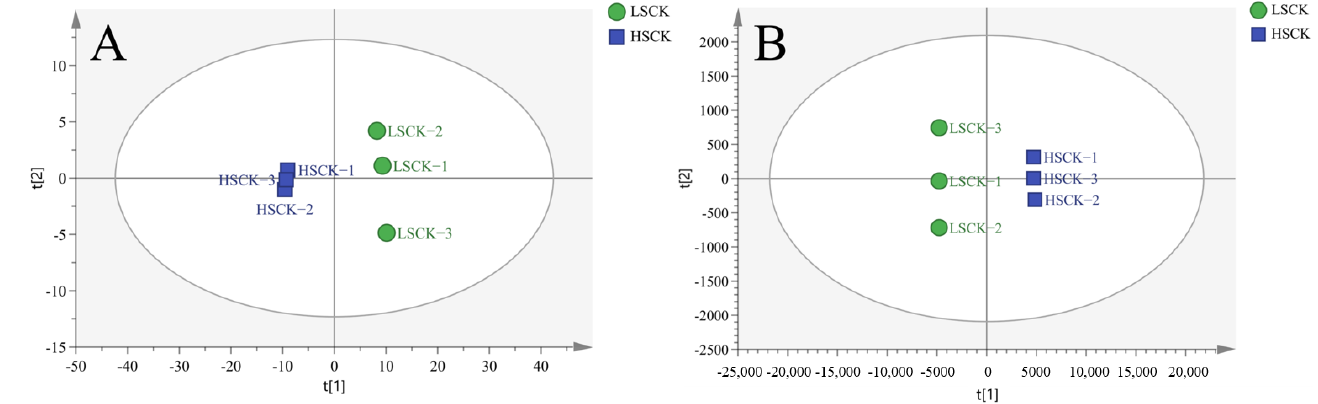
Figure 4. The scatter plots for PCA ( A ) and OPLS-DA ( B ) of LSCK and HSCK. Table 2. Quality parameters of PCA models.